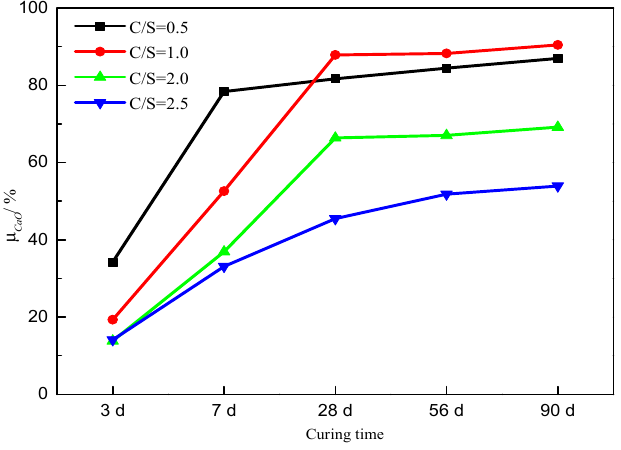
Figure 6. μ CaO values of the samples. Figure 6. µ CaO values of the